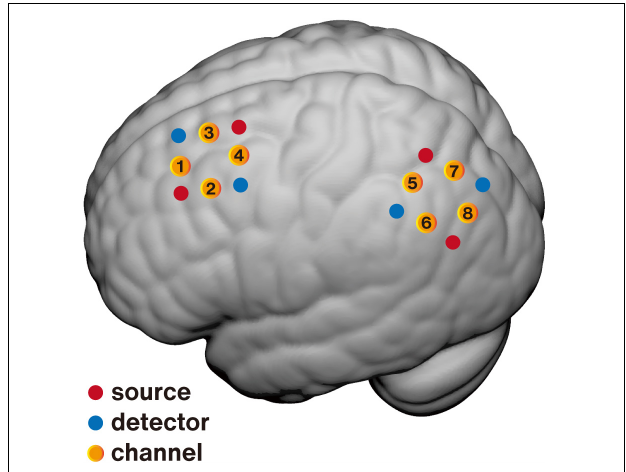
FIGURE 1 | Schematic of fNIRS channel localization on the brain surface. Averaged positions for sources (red), detectors (blue), and channels (yellow) are overlaid on an MNI-152 canonical brain surface (MNI coordinates were generated using NFRI spatial registration toolbox developed by Singh et al., 2005). The premotor area (PMA, channel 4) was selected as the feedback target for the control group and the lateral parietal cortex (LPC, channel 8) for the experimental